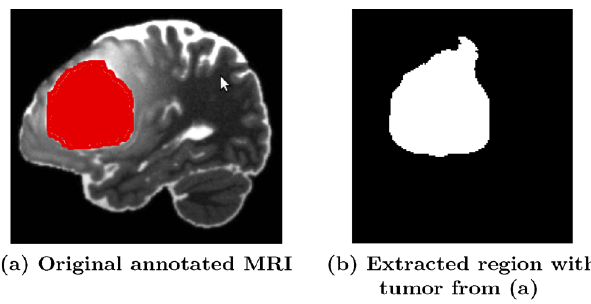
Fig. 11 Examples of annotated and extracted region with tumor for MRI image using proposed